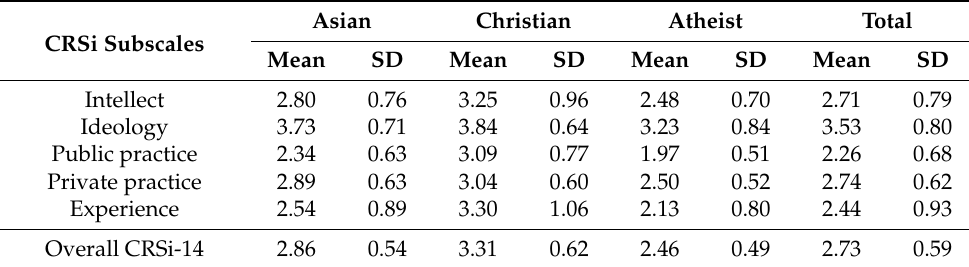
Table 6. Cross-tabulation between CRSi-14 subscales and religious affiliation.